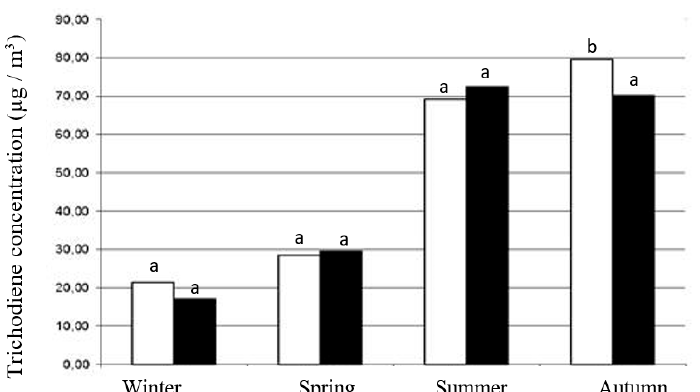
Figure 1. Trichodiene concentration ( μ g/m 3 ) in the atmosphere of poultry houses (commercial farms: black; backyard farms: white) in the annual cycle. a, b—different in the row for each of the two analyzed chow systems; significance was set at the value of 0.05.